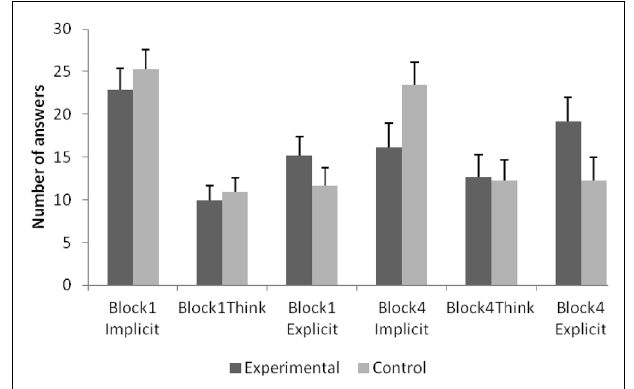
FIGURE 2 |The number of implicit and explicit type of answers in Blocks 1 and 4 by condition. Error bars indicate Standard